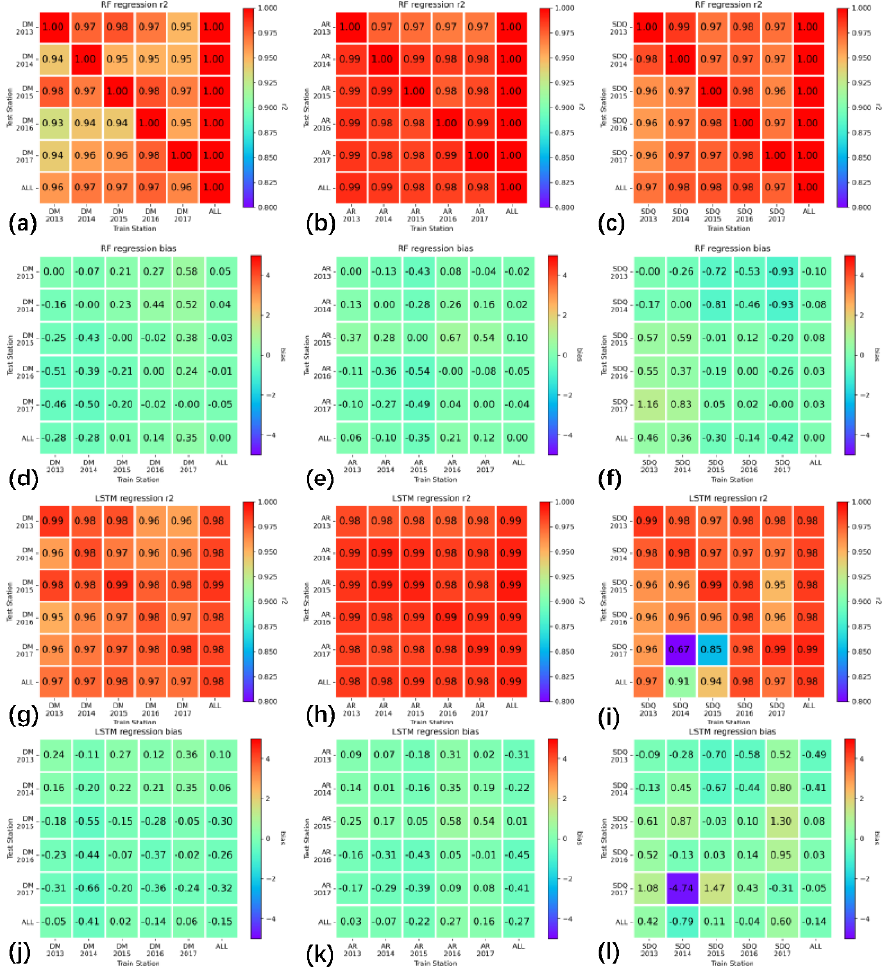
Figure A1. The R 2 and bias of predicted results by RF and LSTM regression method with different Figure A1. The 𝑅 (cid:2870) and bias of predicted results by RF and LSTM regression method with different training data. ( a , b ) correspond to R 2 and bias of RF, respectively. ( c , d ) correspond to R 2 and bias of training data. ( a , b ) correspond to 𝑅 (cid:2870) and bias of RF, respectively. ( c , d ) correspond to 𝑅 (cid:2870) and bias of LSTM, respectively. LSTM, respectively.